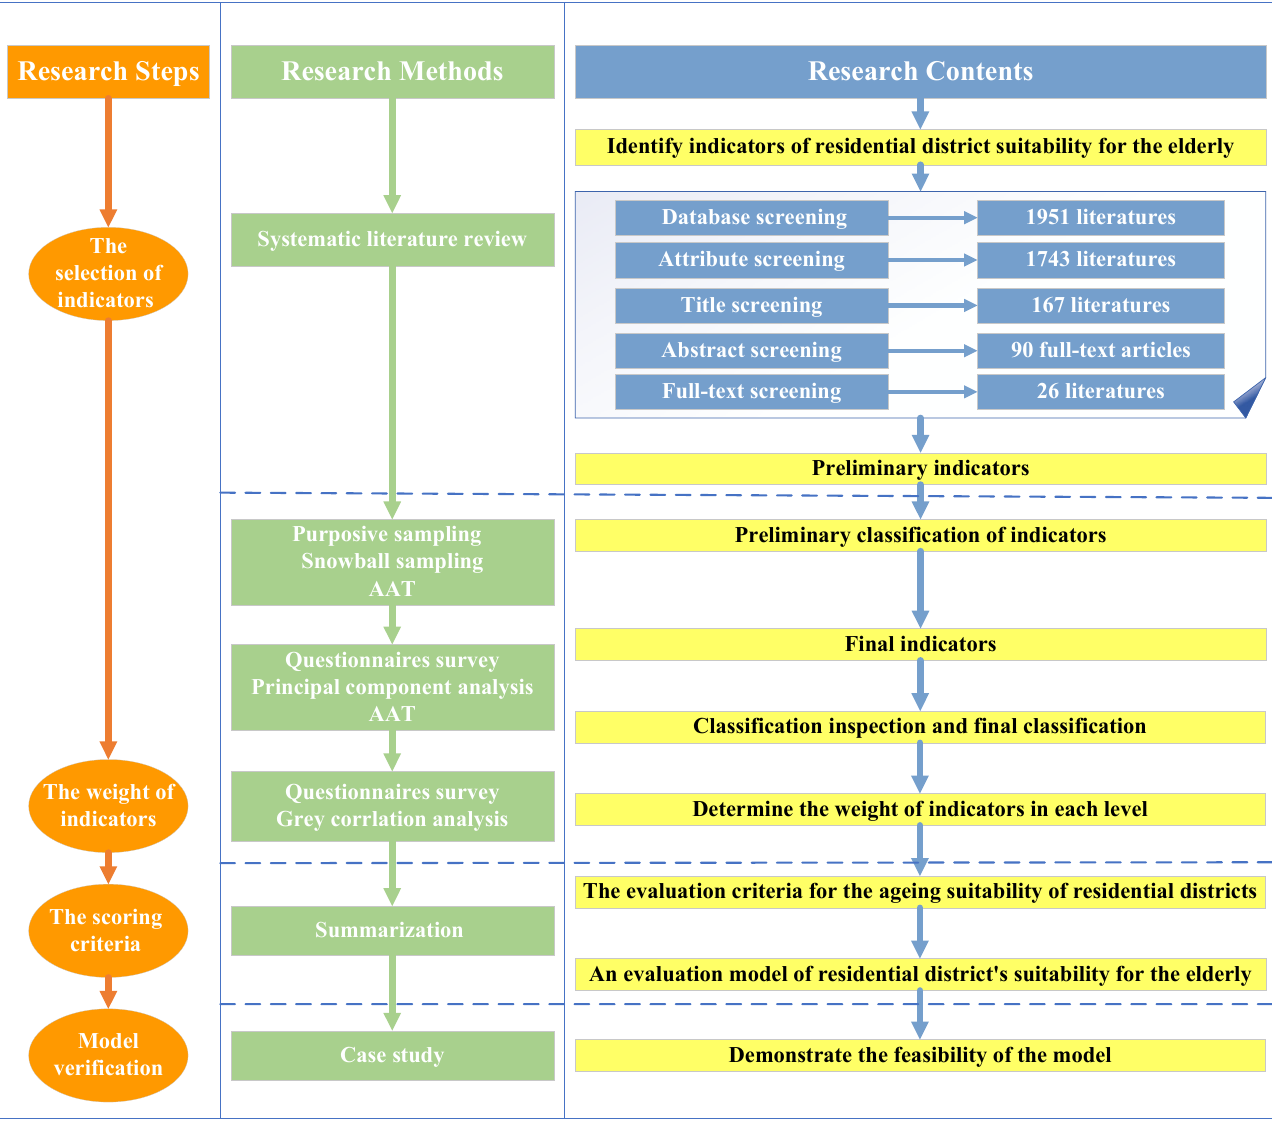
Figure 1. Research framework.